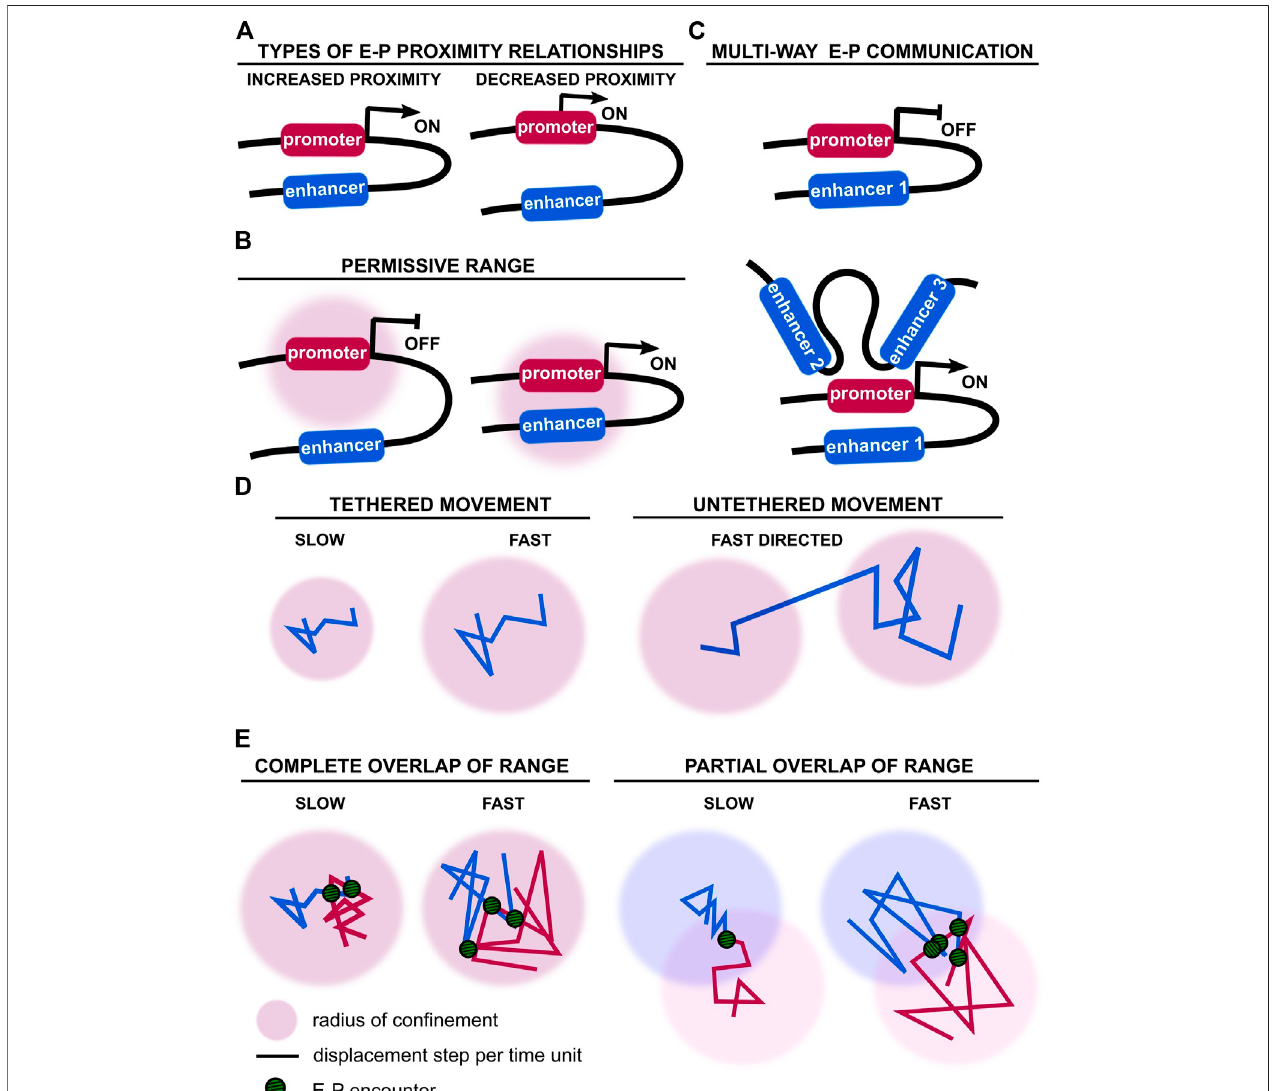
FIGURE 1 | Enhancer-promoter distance and movement vary during transcriptional control. (A) Alternative types of observed and theoretical enhancer-promoter distance relationships during transcriptional activation or repression (Chen et al., 2018; Alexander et al., 2019). Different modes of enhancer-promoter activation have been observed fordifferentgenes,but alsoforthesamegeneindifferentdevelopmental contexts (Amano etal.,2009;Williamsonetal.,2016;Benabdallah etal.,2019). (B) Physical engagement of a promoter by its enhancer(s) may not be necessary. Enhancer movement within a permissive range may be suf fi cient to activate the promoter (Furlong and Levine, 2018). (C) Example of a promoter regulated by multiple enhancers. A promoter may not engage with all enhancers simultaneously for activation (Hnisz et al., 2017; Will et al., 2017; Gonen et al., 2018; Osterwalder et al., 2018). (D) Alternative types of chromatin movement have been reported, ranging from slow to fast, and existing in tethered and untethered conformations (Khanna et al., 2014; Basu et al., 2020). (E) Encounter frequency and duration of E-P communication is dependent on chromatin velocity and respective radii of con fi nement.